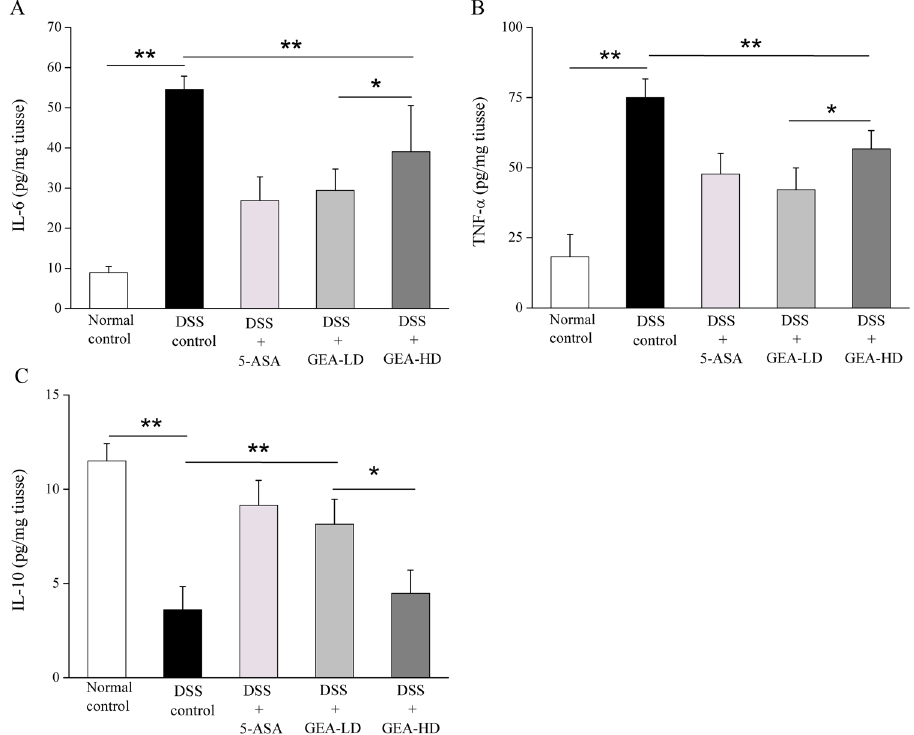
Figure 12. Turkish galls inhibits the expression of pro-inflammatory factors TNF- α , IL-6 and increases anti- inflammatory IL-10 in mice with DSS-induced UC. Turkish galls reduced the expression of inflammatory cytokines ( A ) IL-6, ( B ) TNF- α and increased the expression of ( C ) IL-10. An ELISA demonstrated that TNF- α and IL-6 were significantly higher in the DSS control group than in the GEA-LD/HD group (P < 0.01). IL-10 expression in DSS-induced mice was significantly enhanced by Turkish galls administration. The values are expressed as the mean ± S.D. * P < 0.05, ** P < 0.01, *** P <